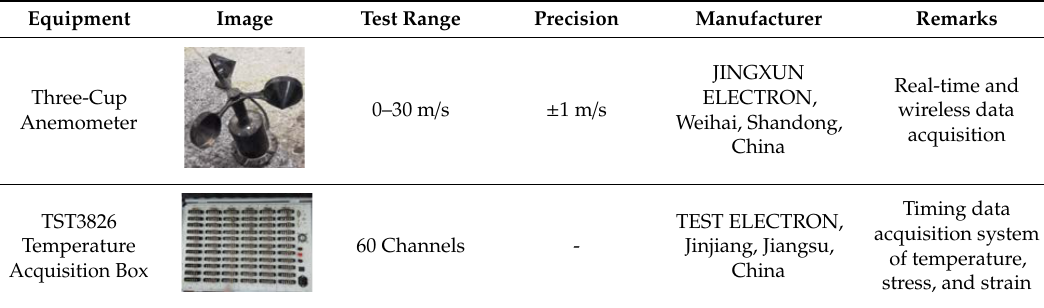
Figure 3. The overall layout of the spatial grid structure model. 3. Analysis of Temperature Field Test Results 3.1. Temperature Field Distribution of Structure Model The experiment was performed continuously for one month. Due to the significant amount of test data, the highest temperature was measured on 16 August, and it was taken as the representative to analyze the temperature distribution under solar radiation. Figure 4 shows the monitoring thermal boundary parameters. The maximum value of the ambient temperature is 32 °C at 12:00. The strong solar radiation is concentrated during 8:00 – 17:00, and the maximum radiation intensity is 1276 W/m 2 at 13:00. The wind speed is relatively small, and the highest wind speed is only 0.6 m/s throughout the day.